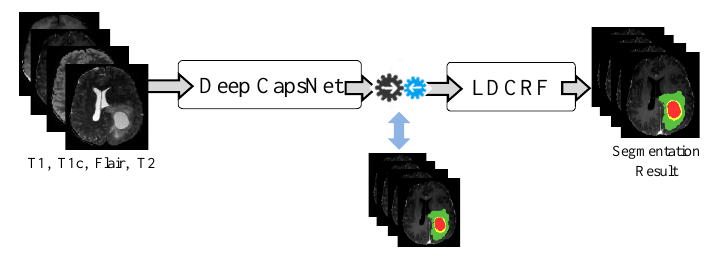
Figure 4. Our brain tumor segmentation model’s